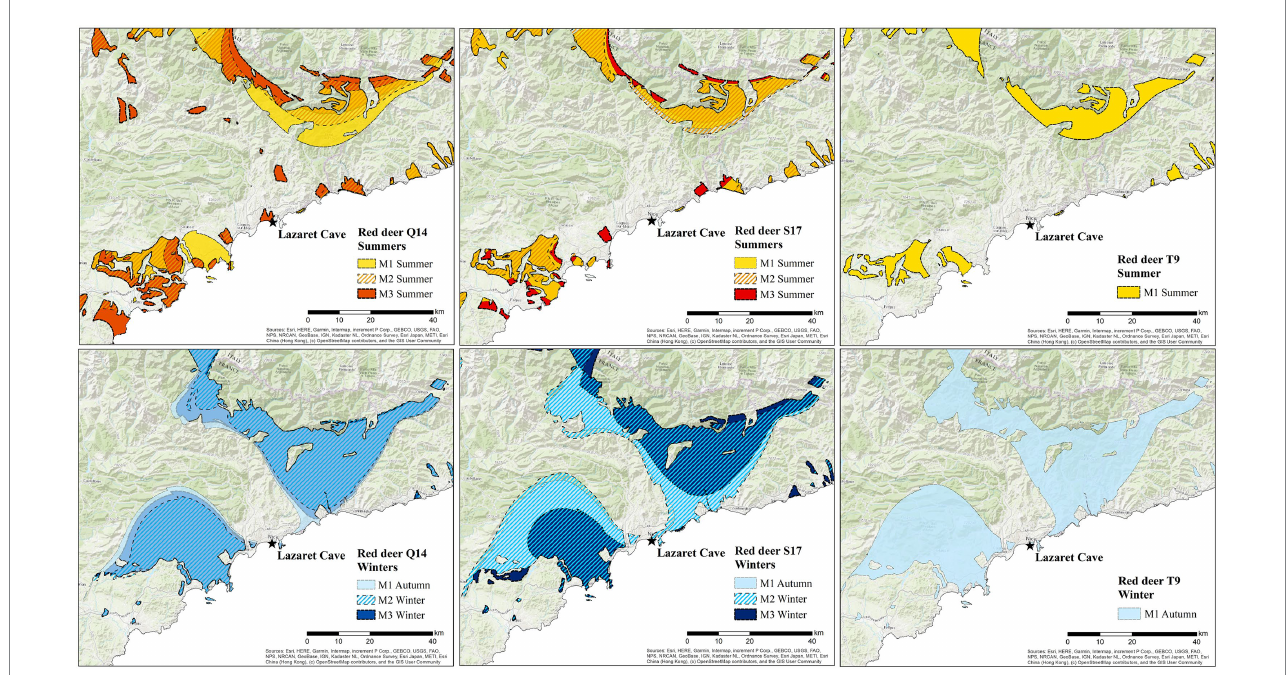
FIGURE 7 Spatial assignment of red deer remains analysed from Lazaret Cave showing likely summer and winter ranges of all red deer with a 90% probability of origin, meaning there is a 90% chance that the red deer were within these locations during the period of enamel formation/mineralisation. Individual teeth are shown in columns, while summer and winter ranges are shown in rows. Each tooth is assigned an individual colour, while M2s are shown with diagonal lines. The landscape shown in this image is within the dashed rectangle in Figure 4; Esri